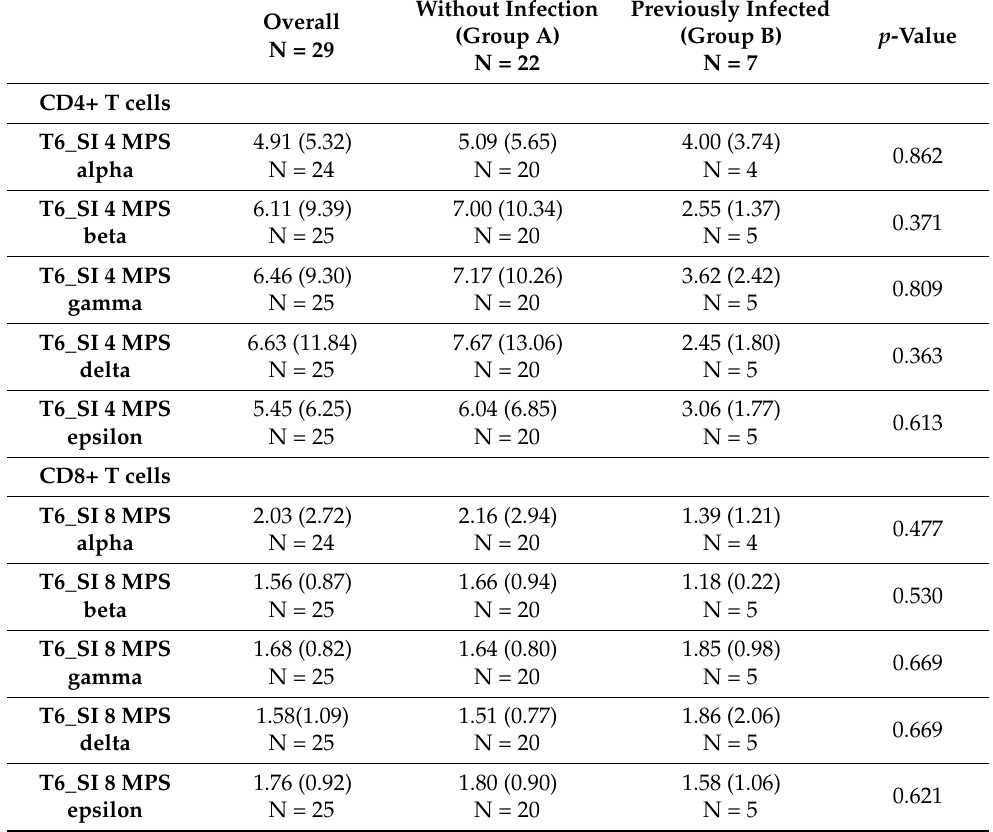
Table 2. Evaluation with activation-induced cell marker assay (AIM) of CD4+ and CD8+ T cell responses against different SARS-CoV-2 virus variants using Spike peptide megapools (MPS). The values of Stimulation Index (SI) are expressed as a mean (standard deviation, SD). The values are only available for T6 (six months after of the second dose). The Mann–Whitney test was performed. MPS: Spike peptide